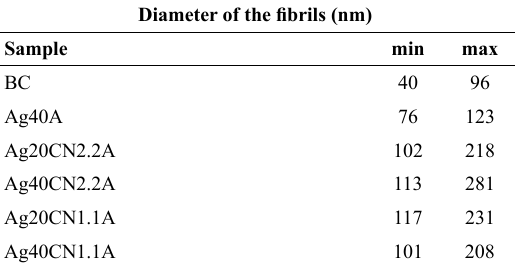
Table 3. Diameter of the fibrils of BC membranes thermally treated in an autoclave.